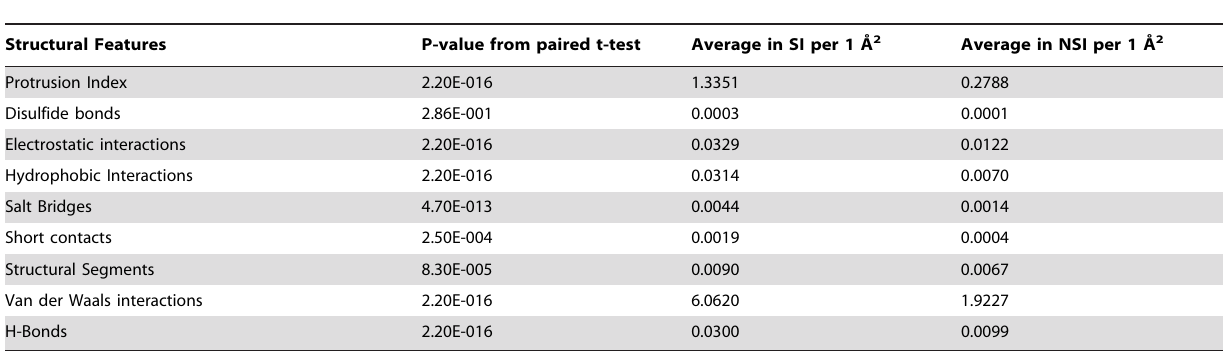
Table 4. Structural features with their average values in SI and NSI and p-value generated from paired t-test.